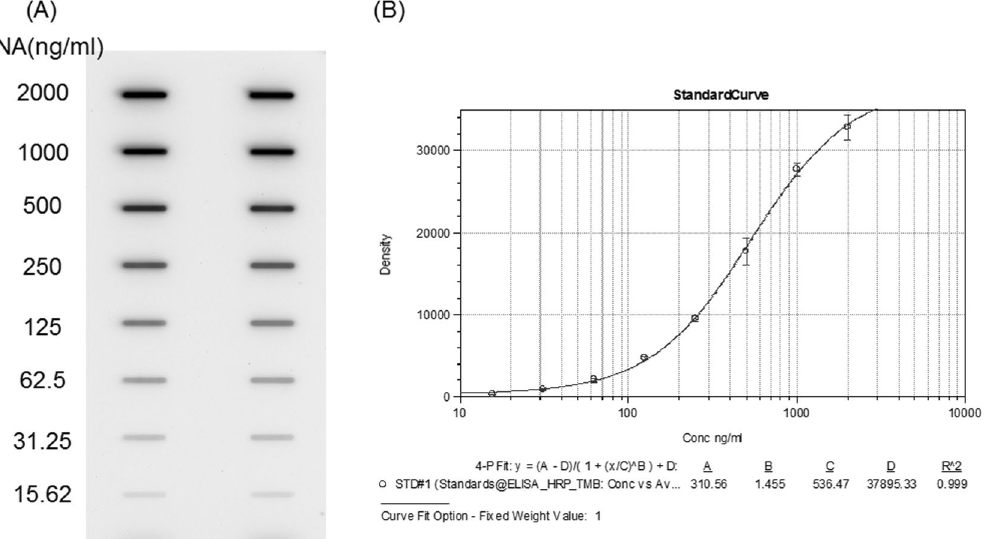
Figure 5. Development of standard curve for NA quantification using slot blot. Panel A: quantitative detection of NA using CAN1 antibodies against N1: the N1 antigens at various concentrations were loaded onto NC membrane. The membrane was then incubated with the CAN1 antibodies, followed by detection with anti- rabbit IgG peroxidase conjugate. Similar results were obtained with CAN2 and CANB antibody binding to their corresponding NA antigens (not shown in the figure). Panel B: standard curve for the quantification of N1: the currently accepted 4-parameter logistic (4-PL) model was employed for the calibration curve fitting in the immunoassays. Original pictures see Supplementary Figure S4.